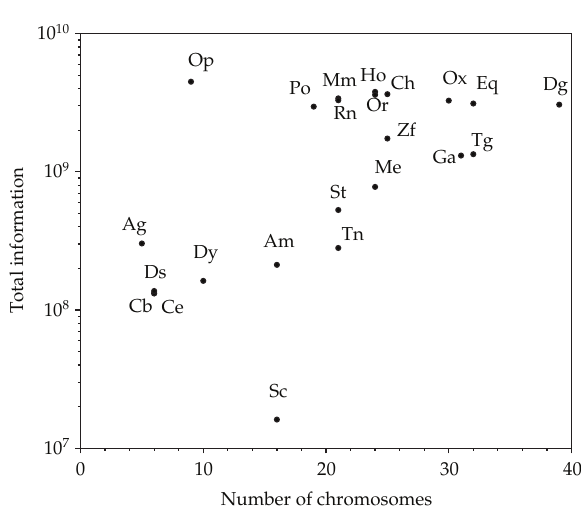
Figure 6: Total information for each species versus the number of chromosomes with n (cid:7) 8.